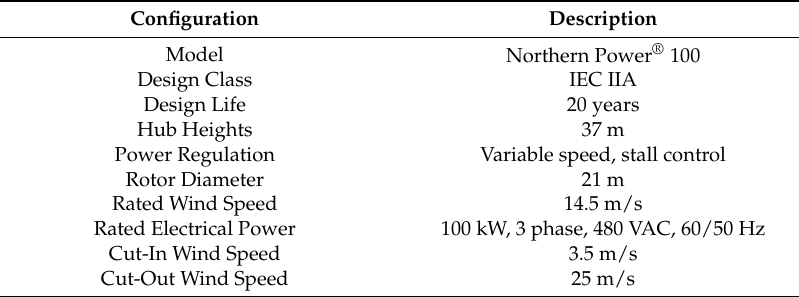
Table 1. Prototype wind turbine parameter.